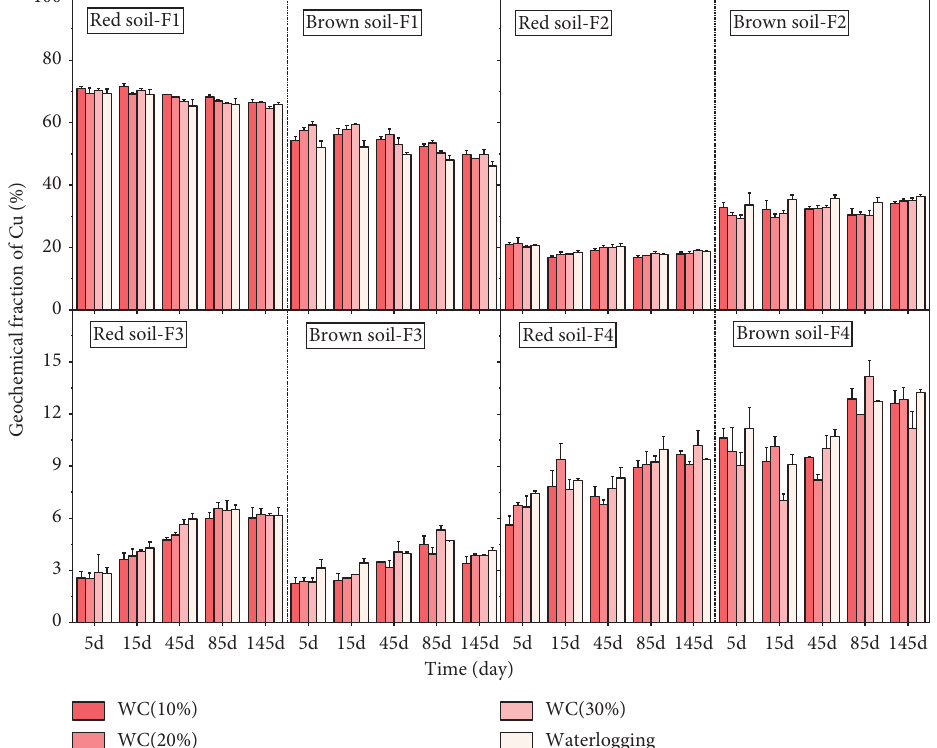
Figure 6: Changes of Cu fractions in different soil water contents as a function of contact time.